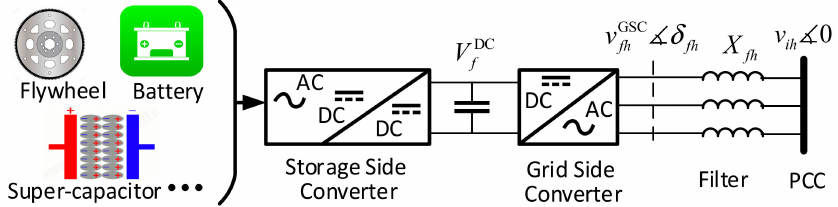
Figure 3. General connection of the ESSs by a voltage source inverter to the PCC.